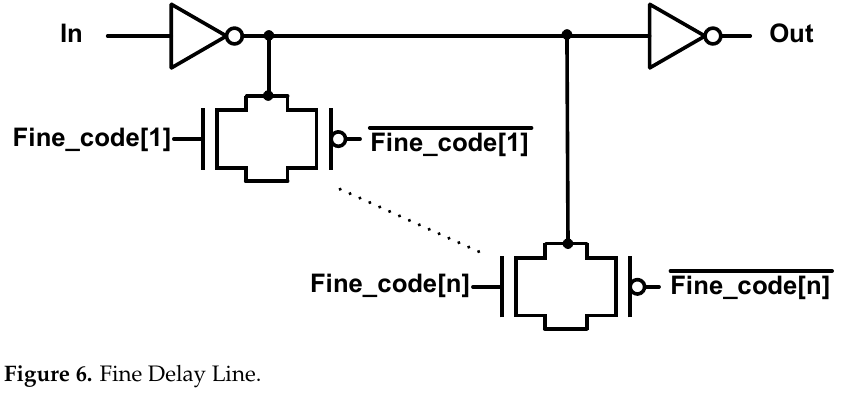
Figure 6. Fine Delay Line.